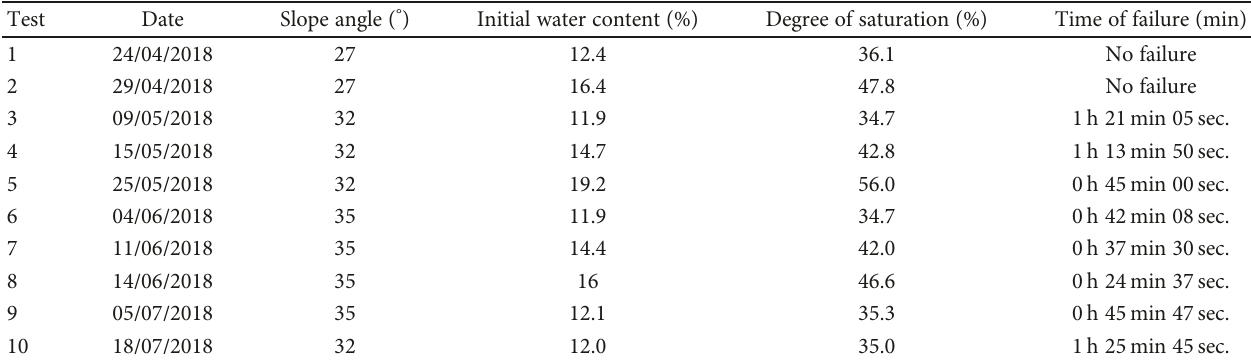
Figure 5: (a) Placement of a 4 cm soil layer within the fl ume; (b) position and installation depth of the 8 sensors according to a schematic upper view of the soil slope model; (c) the soil slope model just before the beginning of a test. The lateral view allows to notice the wedge- shaped slope at the termination of soil volume. Table 2: Initial soil conditions and time of failure for each performed fl ume